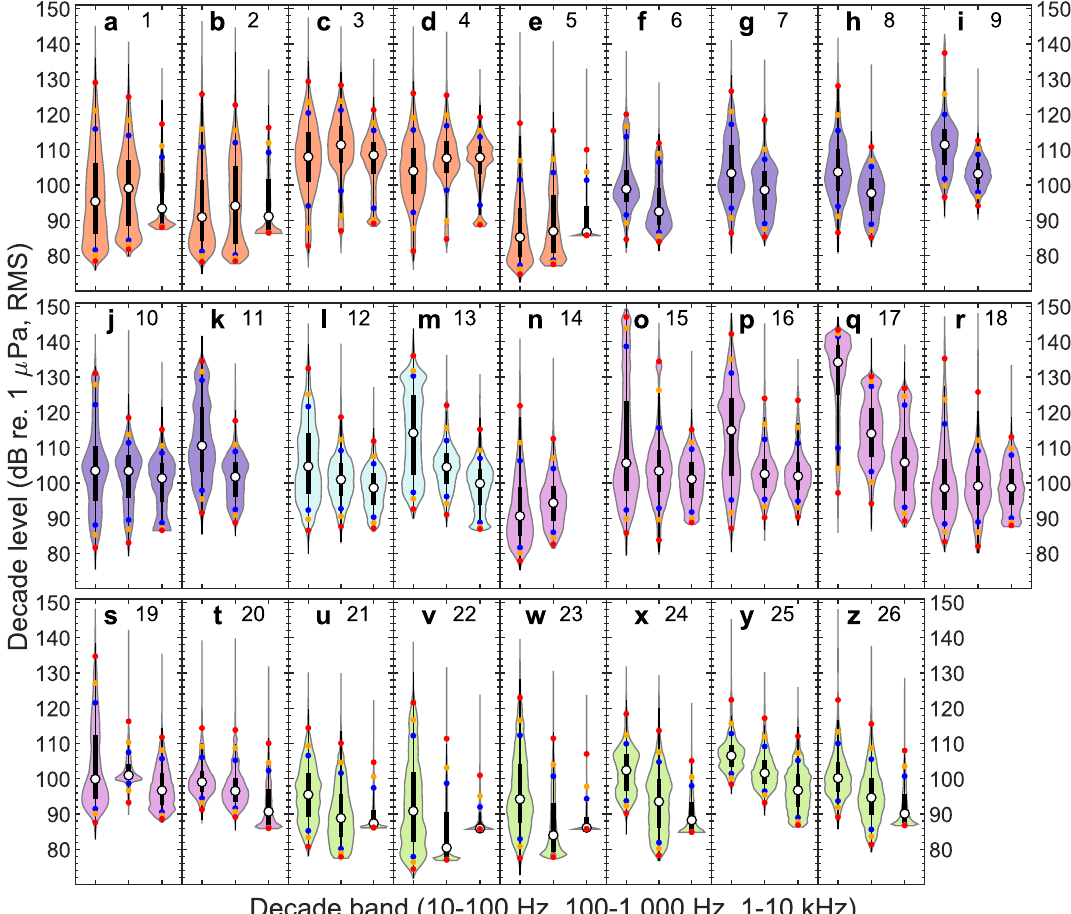
Figure 2. Decade level distributions (asynchronous) for the 26 recording stations. ( a – z ) Distributions of 10 s decade level estimates are shown for each station in the decade bands 10–100 Hz (VLF), 100–1000 Hz (LF), and 1–10 kHz (MF, only computed when sampling rates were sufficiently high). The decade level distributions are depicted as violin plots overlaid with box plots (interquartile range: thick black lines; whiskers: thin black lines). Exceedance levels are shown as coloured dots (L 50 or median: white; L 90 and L 10 : blue; L 95 and L 5 : orange; L 99 and L 1 : red). Stations numbers and region colours (Melville Bay: red, Baffin Bay: blue, South Greenland: cyan, Tasiilaq: magenta, Greenland Sea: green) as in Table 1 and Fig.